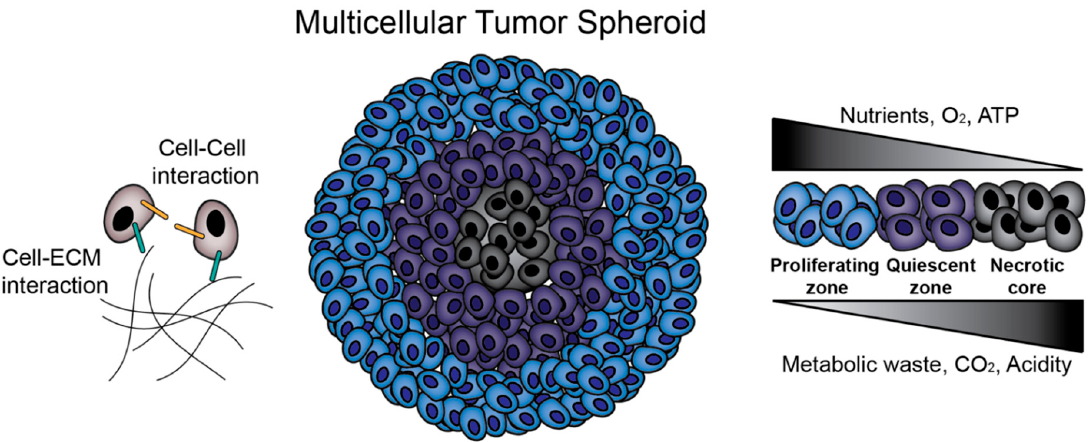
Figure 1. Multicellular tumor spheroids (MCTS) biology. MCTS provide an in vitro platform for the investigation of cell–cell and cell–extracellular matrix (ECM) interactions. Additionally, MCTS mimic in vivo solid tumors in terms of nutrient, oxygen and pH gradients and zone formation.